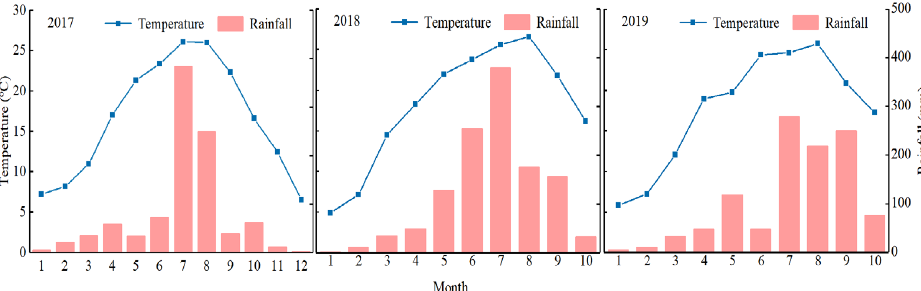
Figure 1. Meteorological data of the experimental area, including temperature and rain full in 2017–2019.